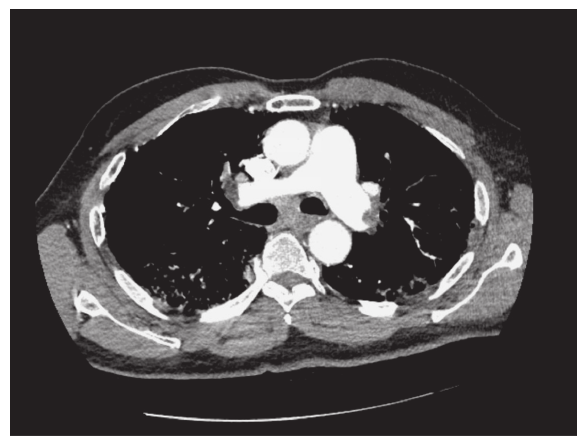
Figure 3: CT angiogram showing pulmonary emboli in the distal right and left pulmonary